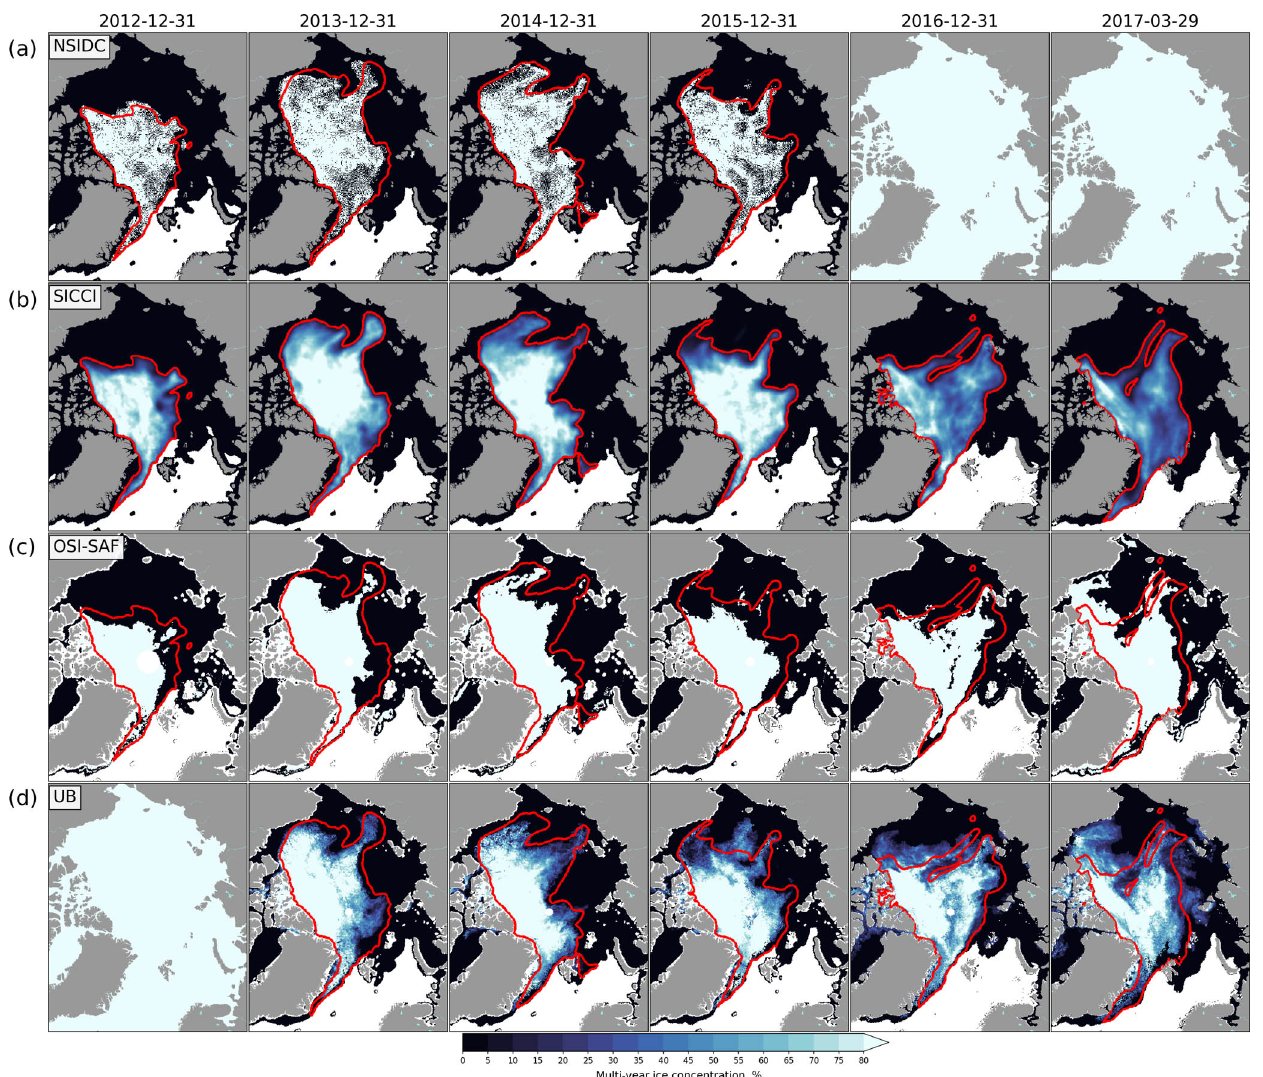
Figure 7. Comparison of MYI concentration estimated from the NSIDC SIA product (a) , from the SICCI SIA product (b) , downloaded from OSI SAF (c) and from University of Bremen (d) . Daily maps are generated for 31 December of the years from 2012 to 2016 and for 29 March 2017 from available data. Red contours denote extent of MYI in the SICCI product at 5%